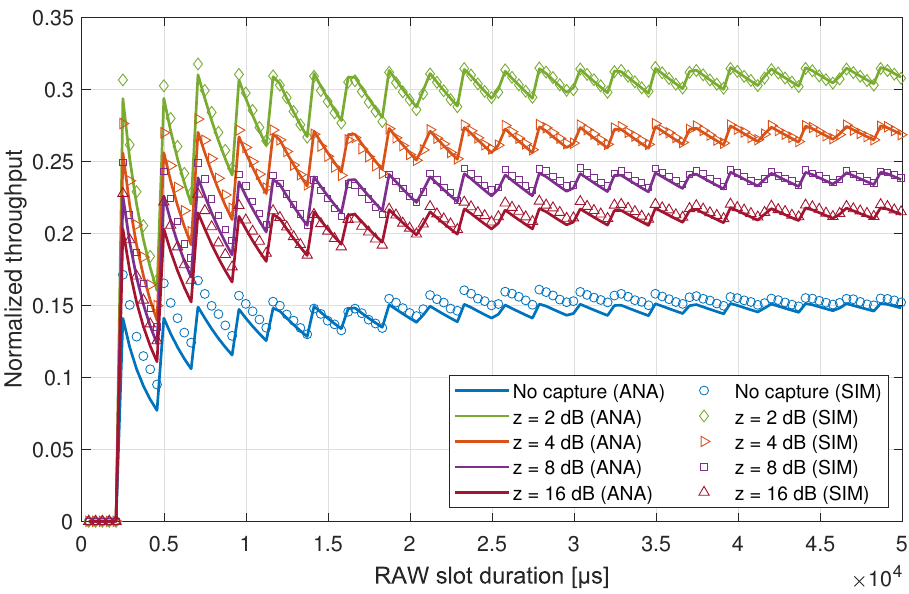
Figure 8. Impact of the capture threshold on the RAW slot